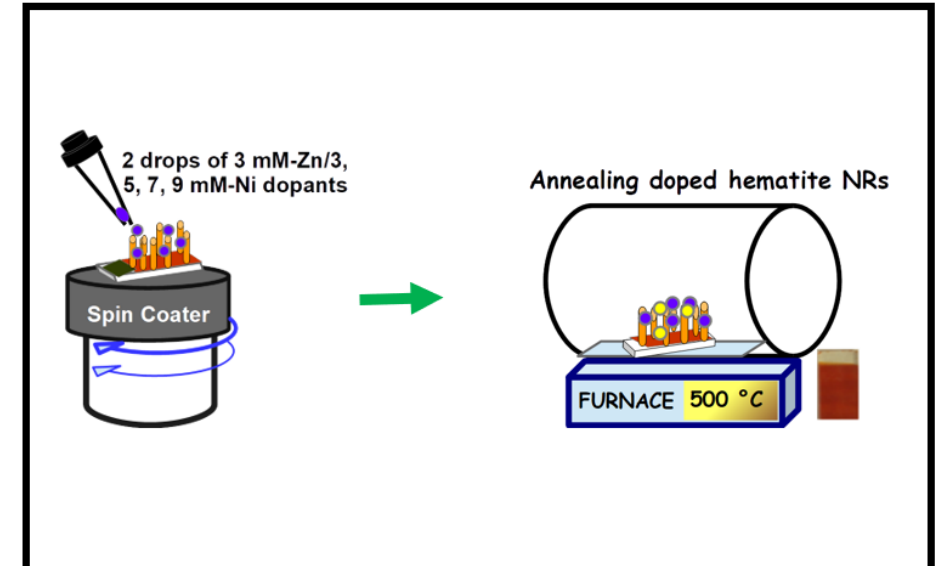
Figure 2. Illustration of Zn/Ni facile co-doping of hematite NRs.